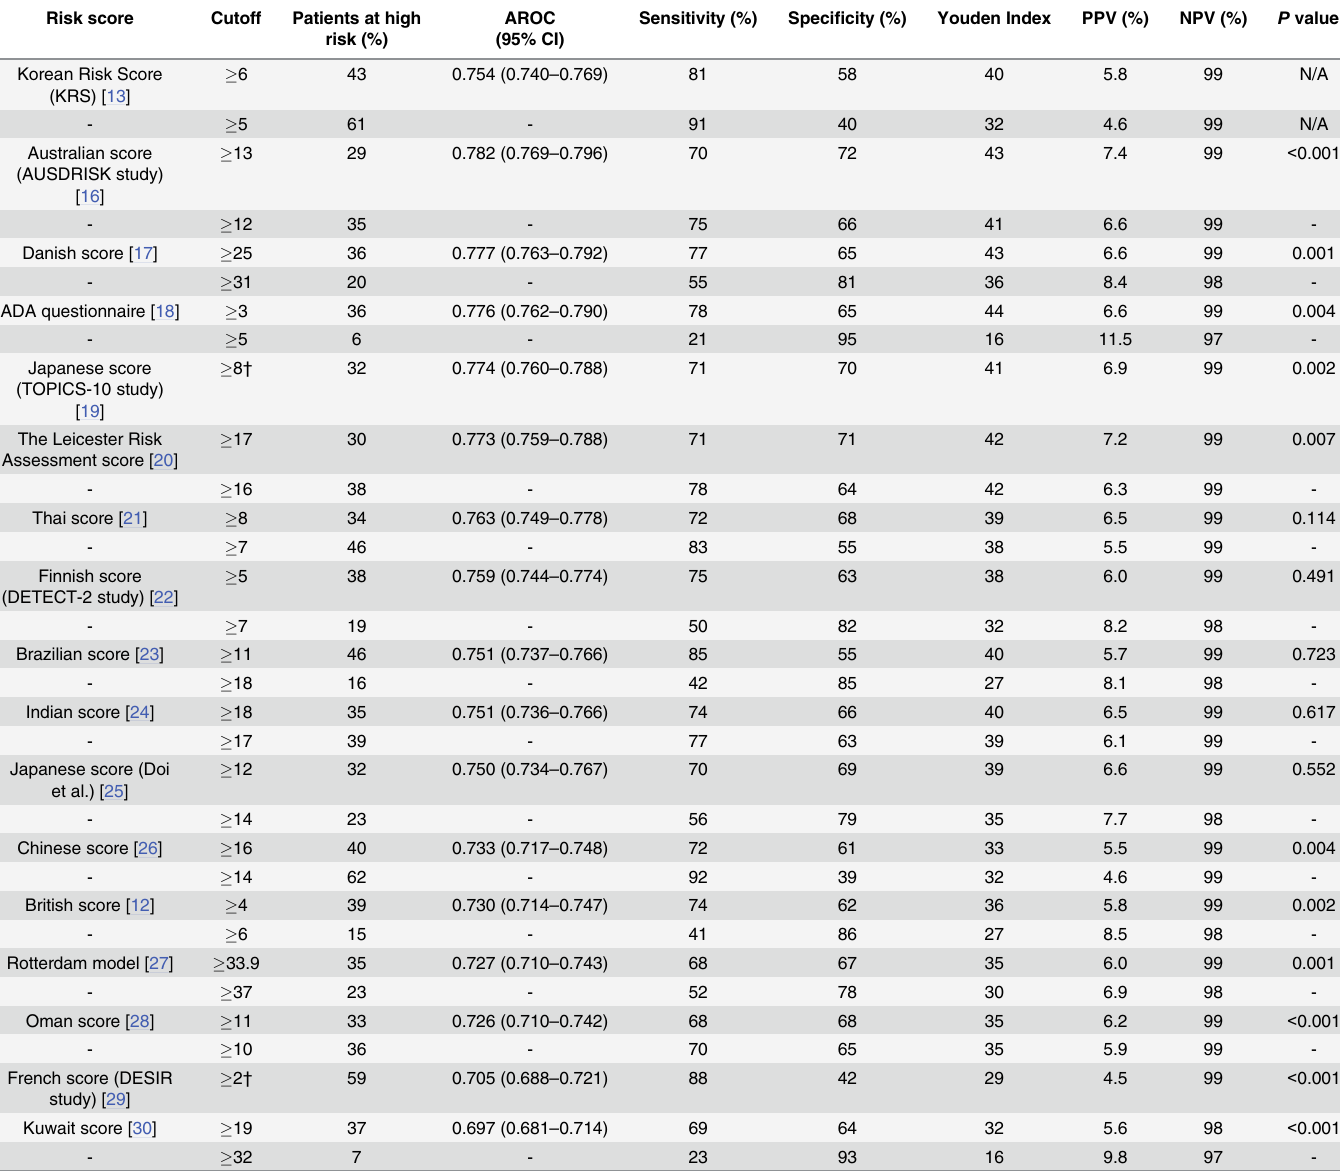
Abbreviations: AROC, area under the curve of receiver operating characteristic curve; CI, con fi dence interval; PPV, positive predictive value; NPV, negative predictive value; N/A, not applicable Risk scores other than the KRS were arranged in the order of higher AROC values. The performance of different risk scores for screening for undiagnosed diabetes was evaluated with each score ’ s original cutoff value and the new cutoff value showing the highest Youden index. The results in the upper row of each score are based on the new cutoff value with the highest Youden index. The results in the bottom row of each score are based on the original cutoff